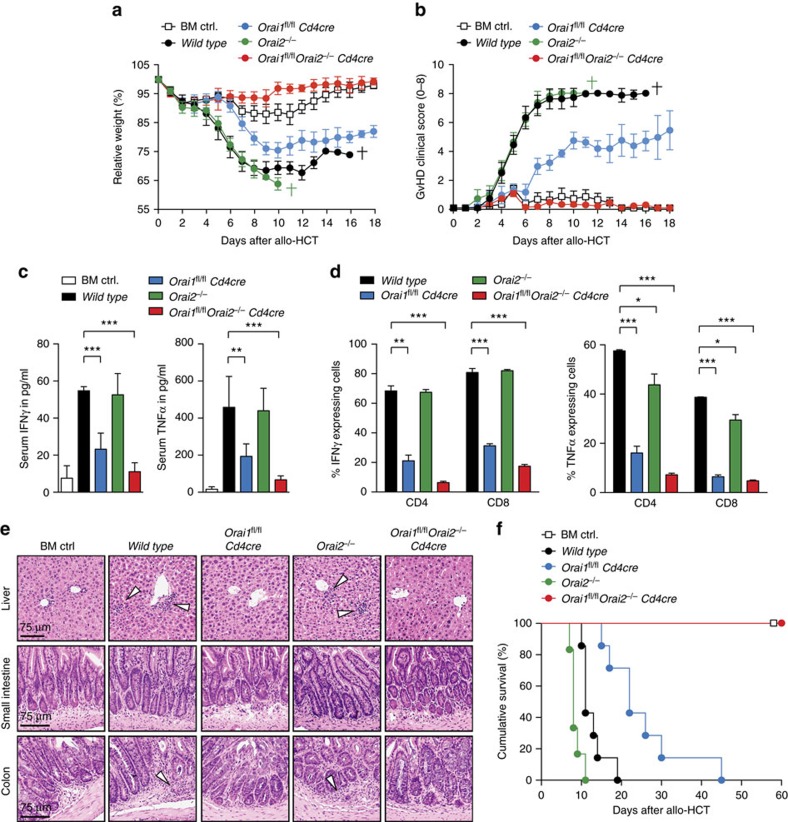
Orai1/Orai2-deficient T cells fail to cause GvHD after adoptive transfer into allogenic host mice.(a) Weight loss of BALB/c host mice after transfer of allogenic T cells from WT, Orai1fl/flCd4cre, Orai2−/− and Orai1fl/flOrai2−/−Cd4cre (DKO) donor mice. BALB/c mice were lethally irradiated with 8 Gy and transplanted with 5 × 106 allogenic C57BL/6 WT BM cells together with 1.2 × 106 allogenic C57BL/6 T cells from WT, Orai1fl/fl
Cd4cre, Orai2−/− and DKO mice. Mice without T cell transfer (BM ctrl.) were used as control; means±s.e.m. of seven mice. (b) Clinical scores of GvHD pathology (0–8) after allogenic T cell transfer described in a; means±s.e.m. of seven mice. (c) Serum concentration of IFNγ and TNFα in host mice 10 days after allogenic T cell transfer as described in a analysed by ELISA; means±s.e.m. of four to five mice. (d) Analysis of intracellular IFNγ and TNFα in WT, Orai1fl/fl
Cd4cre, Orai2−/− and DKO T cells 10 days after transfer and following stimulation with phorbol myristate acetate (PMA)/iono; means±s.e.m. of three mice. (e) Representative H&E-stained microsections of the liver, small intestine and colon of BALB/c host mice 10 days after allogenic transfer of WT, Orai1fl/flCd4cre, Orai2−/− and DKO T cells. (f) Cumulative survival of BALB/c host mice after allogenic transfer of WT (mean survival time (MST): 11 days), Orai1fl/flCd4cre (MST: 22 days), Orai2−/− (MST: 8 days) and Orai1fl/flOrai2−/−
Cd4cre T cells (MST: >60 days); seven mice per group as described in a. *P<0.05; **P<0.005; ***P<0.001 in (c,d) using two-way analysis of variance (ANOVA).